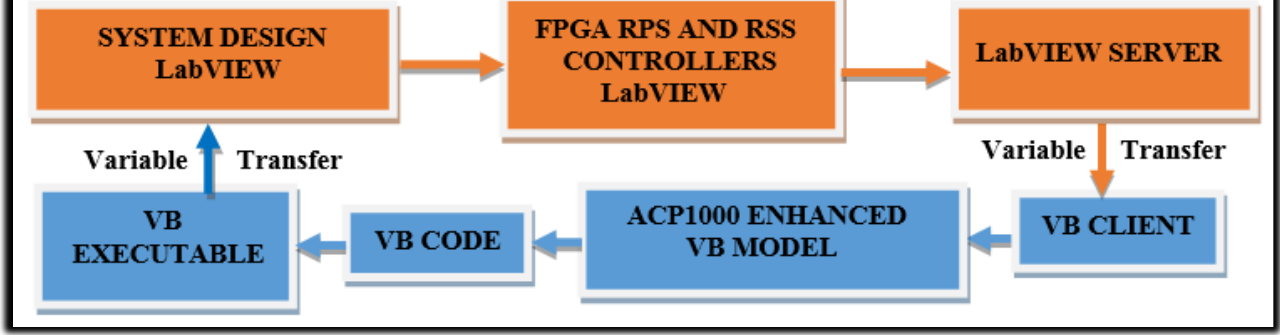
Fig. 1. Configuration of ACP1000 model and FPGA based protection (RPS) and safety (RSS) controllers